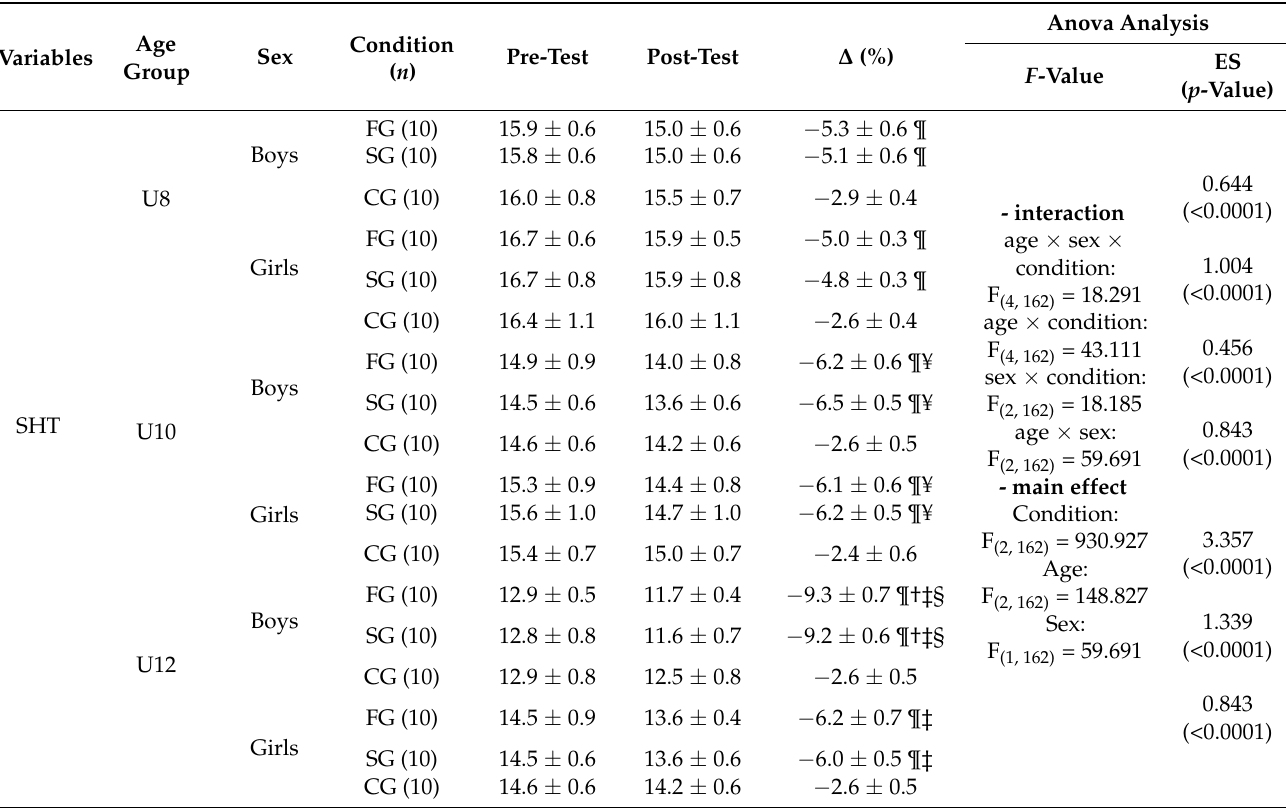
Table 4. Descriptive data for change of direction speed performance (s) in the surface-type plyometric training and control groups at pre-test and post-test ( n =